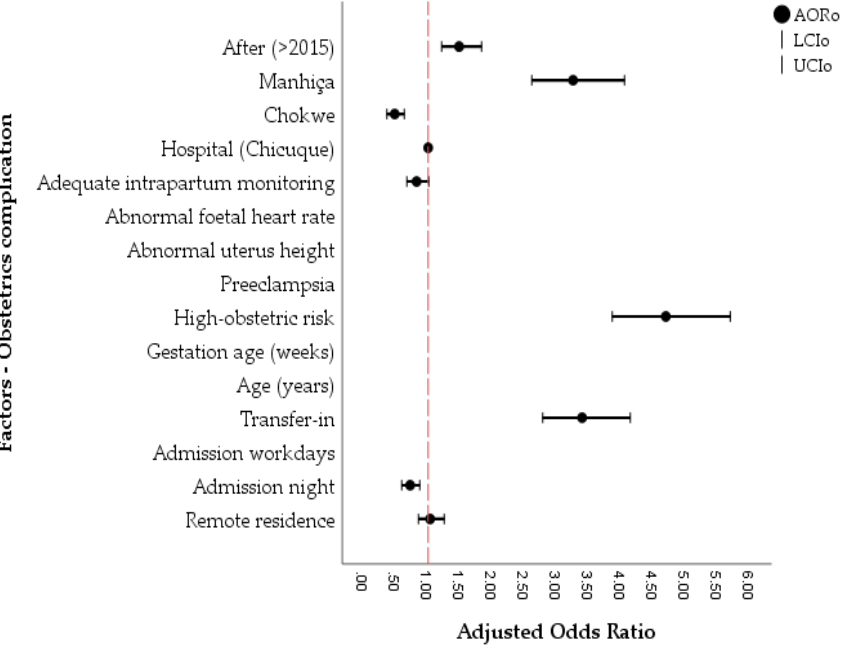
Figure A3. Factors Associated with Neonatal Complications.